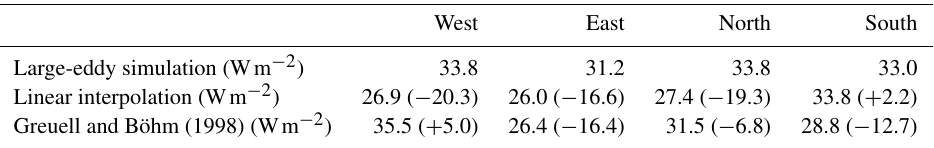
Figure 9. Potential temperature at 2m above the surface for each of the four case experiment. The sites Z1–4 define regions and locations on the glacier which are used for discussion in the results section. The grey dashed lines represent sharp ridges in the study area. Table 2. Comparison of the surface heat fluxes. Shown are the glacier-wide averaged surface heat fluxes from the LES and the estimated fluxes calculated with the bulk approach using different temperature fields as predictor (linearly interpolated and a thermodynamic glacier wind model based on Greuell and Böhm, 1998). The mean relative differences are given in the brackets. West East